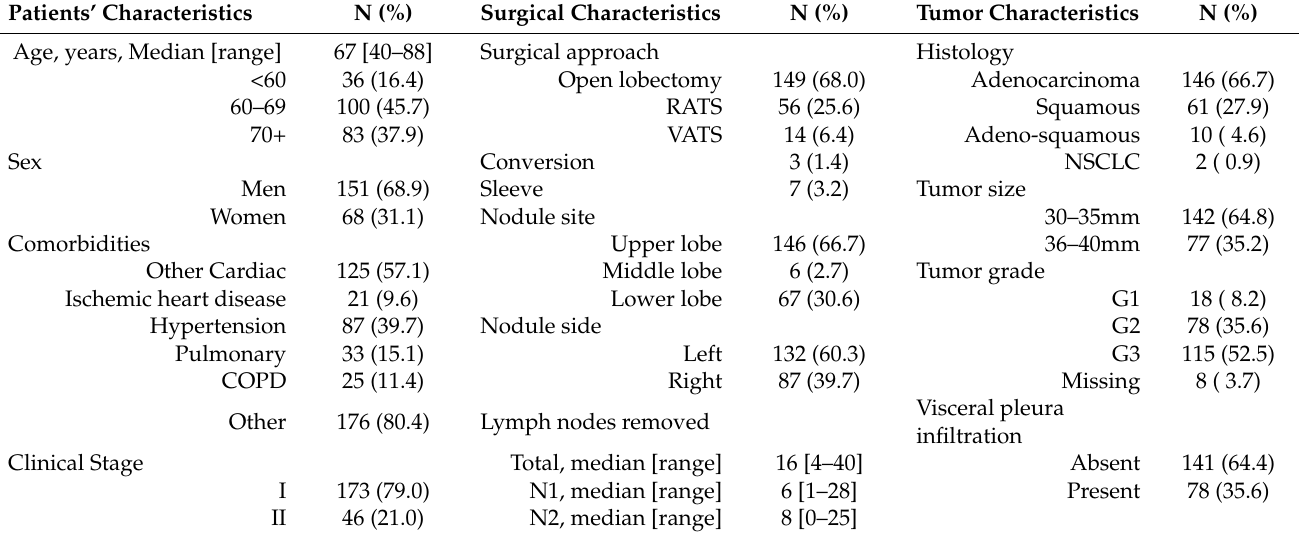
Table 1. Characteristics of 219 patients with stage IB (pT2aN0M0) NSCLC operated at the IEO during 1998–2020, who did not receive neoadjuvant or adjuvant therapy for primary cancer. Patients’